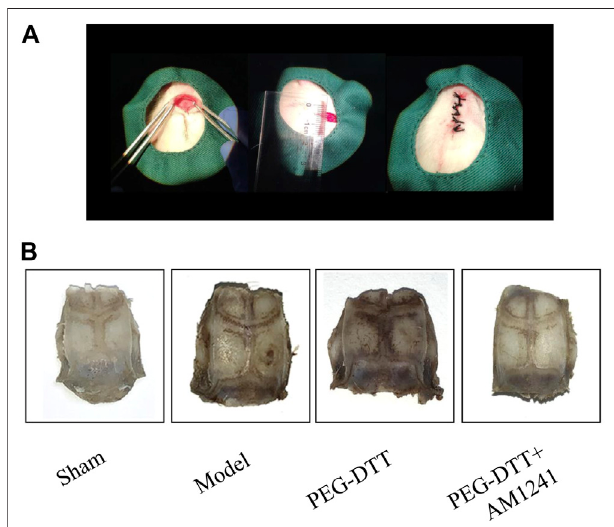
FIGURE 3 | Construction of the rat cranial bone defect model. (A) Surgicalsteps of the ratcranialbone defect model. (B) General observation of the healing of cerebral bone defects.